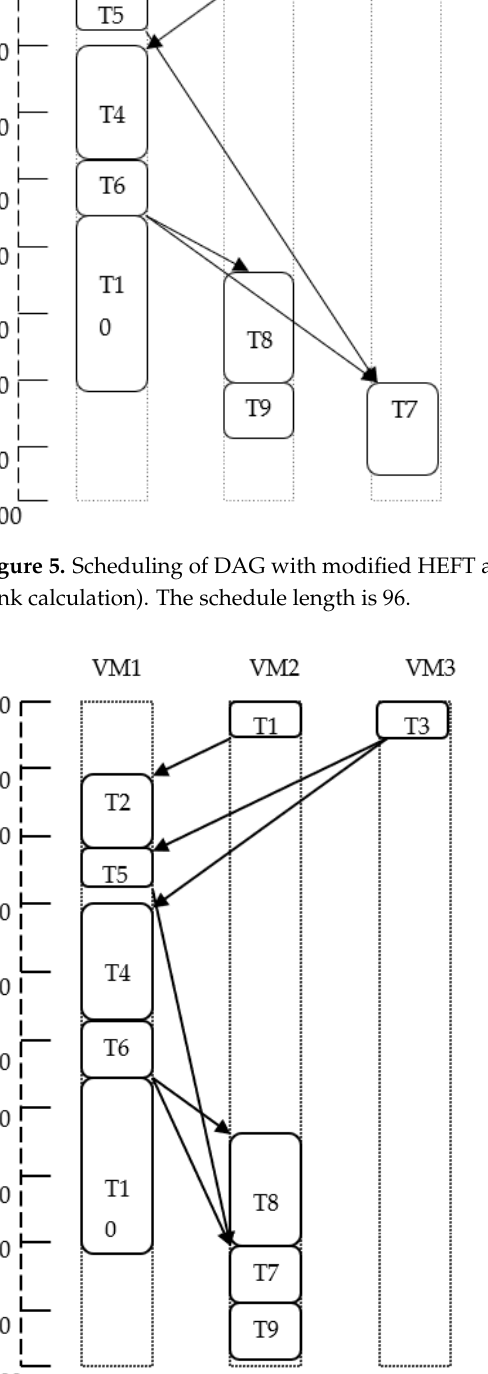
Figure 7. Scheduling of DAG with modified HEFT algorithm (use of minimum schedule length idle slot in processor selection). The schedule length is 89.